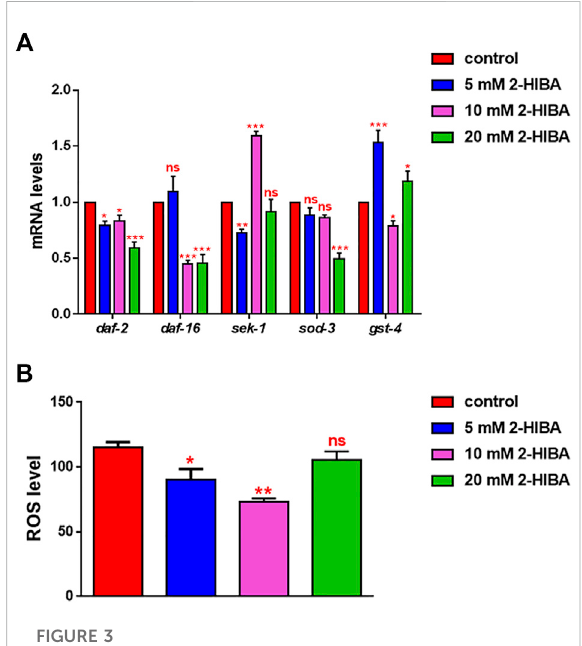
FIGURE 3 Impact of 2-HIBA on oxidative stress responses. (A) Expression of daf-2 , daf-16 , sek-1 , sod-3 and gst-4 genes in N2 worms treated with 5, 10 or 20 mM 2-HIBA and in untreated nematodes at day 1 of adulthood. Histograms show the expression of genes involved in oxidative stress detected by real- timePCR. (B) MeasurementofROSlevelsinN2supplementedwith 2-HIBA compared to untreated control. Experiments were performed in triplicate. Data are presented as mean ± SD (* p < 0.05, ** p < 0.01 and *** p < 0.001; ns: not signi fi cant).